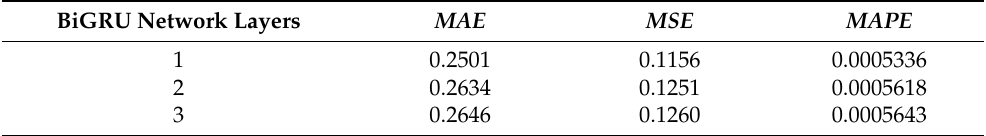
Table 3. Prediction results of BiGRU with different numbers of network layers.